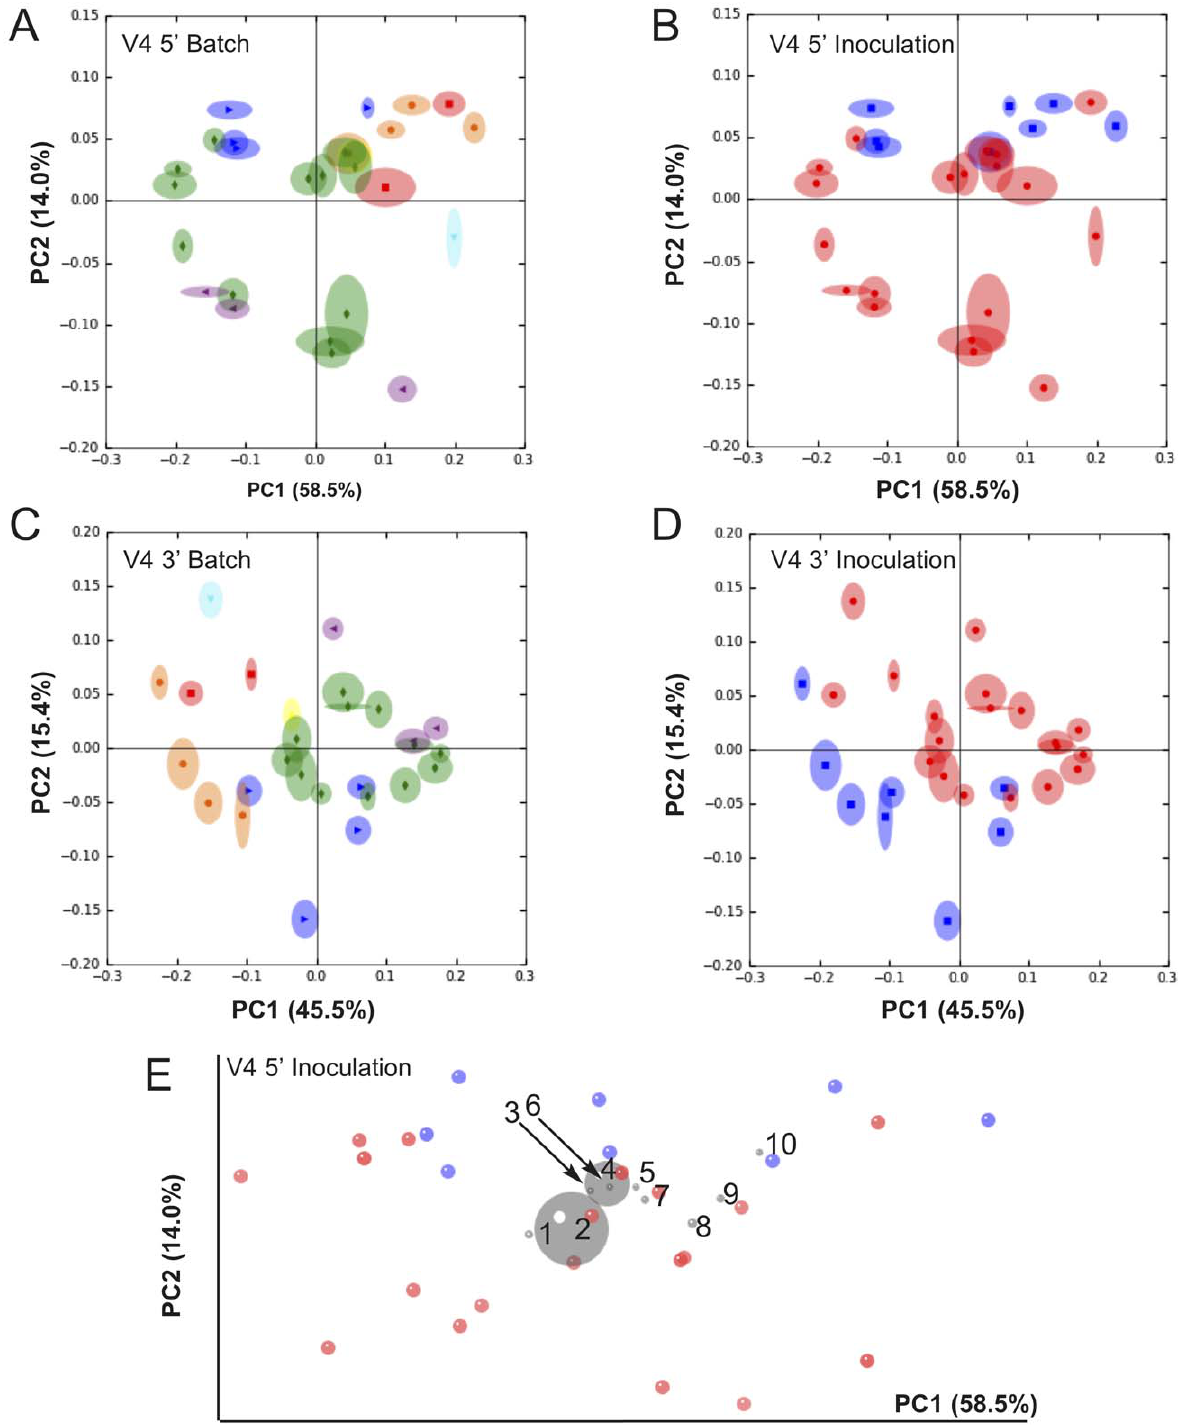
Figure 4. Inoculation and batch direct bacterial diversity of Dolce fermentations. Jackknifed Weighted UniFrac PCoA of V4 sequences categorized by batch number (A,C) and inoculation (B,D,E). Panel A–B: V4 5 9 read weighted UniFrac. Panel C–D: V4 3 9 read weighted UniFrac. Panel E: PCoA biplot displaying OTU (as loadings, grey orbs) correlation to samples categorized by inoculation; OTU labels correspond to ID numbers in Table 1. Color codes for batch-categorization (A,C): Blue=batch 1, 2008 inoculated; Orange=batch 2, 2008 inoculated; Red=batch 3, 2008 uninoculated; Green=batch 4, 2009 uninoculated; Purple=batch 5, 2010 uninoculated; Yellow=2008 press-pan sample 1; Cyan=2008 press-pan sample 2. Color codes for inoculation-categorization (B,D,E): Blue=inoculated; Red=uninoculated.